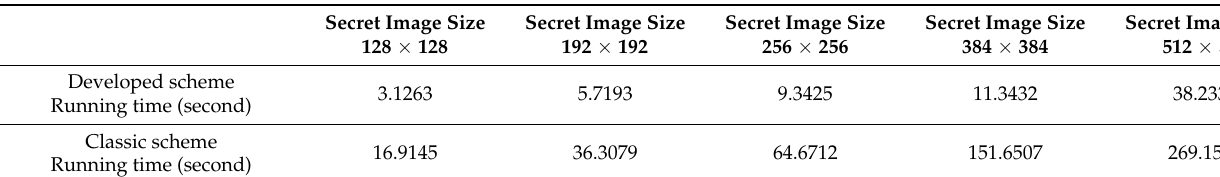
Table 3. Running times with different sizes in GF (2 8 ).